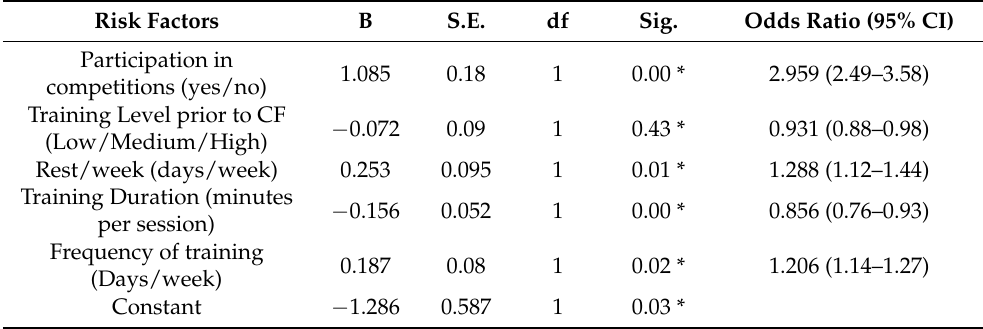
Figure 2. Descriptives of Risk Factors. Table 6. Logistic regression model to predict injuries from five risk factors.